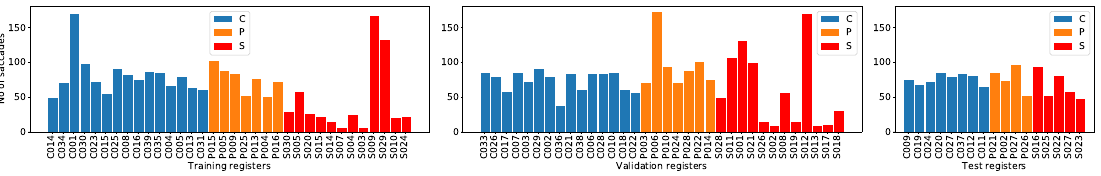
Figure 2. Each plot shows the number of saccades for each register in turn. From left to right , the registers considered for the training, validation and test sets are shown.